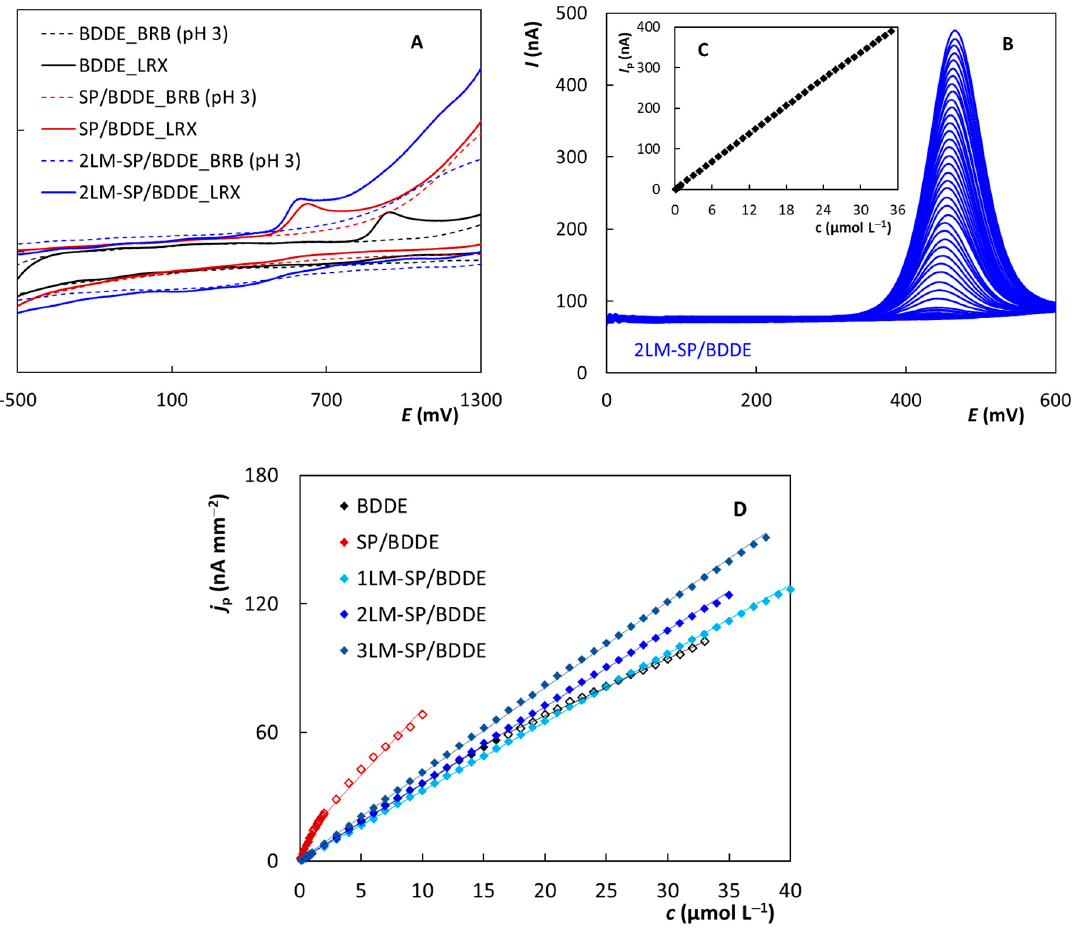
Figure 6. CV voltammograms of 10 μ mol L − 1 LRX obtained on BDDE, SP/BDDE, and 2LM-SP/BDDE ( A ), DP voltammograms of LRX recorded on 2LM-SP/BDDE in dependence on concentration in the range from 0.1 to 35 μ mol L − 1 ( B ), plotted dependence of I p on c (LRX) ( C ), and the corresponding dependences obtained using the tested sensors ( D ) (CV: electrolyte—BRB (pH 3), v = 100 mV s − 1 ; DPV: electrolyte—BRB (pH 3), pulse amplitude = +60 mV, pulse width = 30 ms, v = 40 mV s − 1 ).